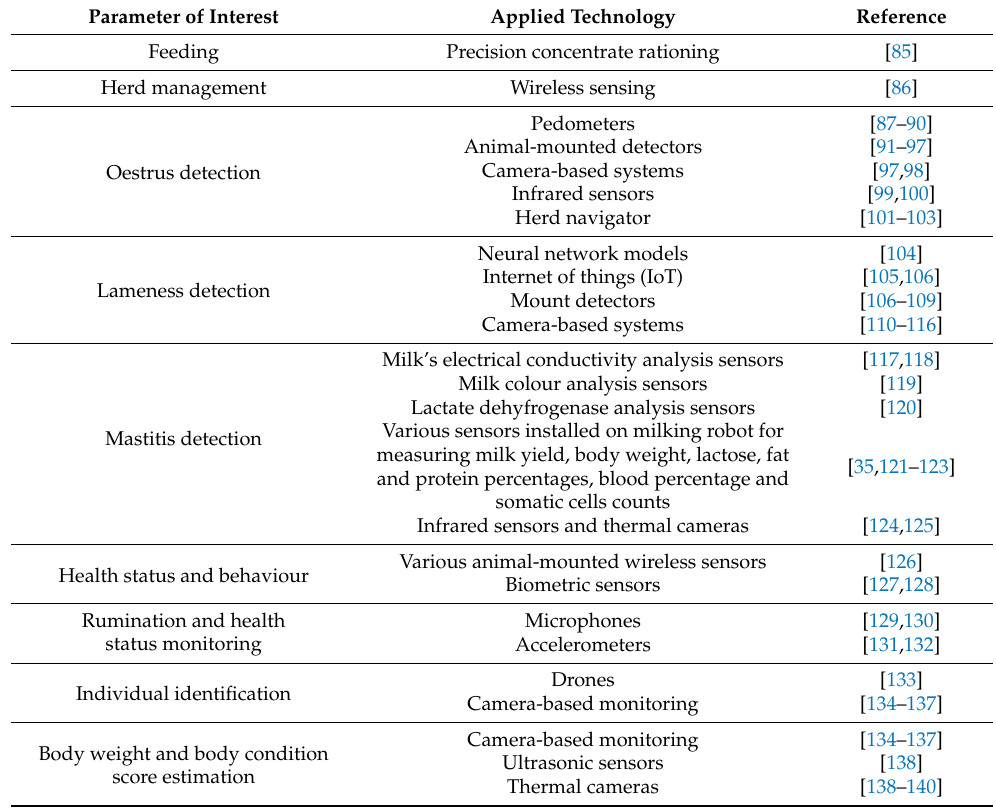
Table 1. Application of precision livestock farming advancements in dairy